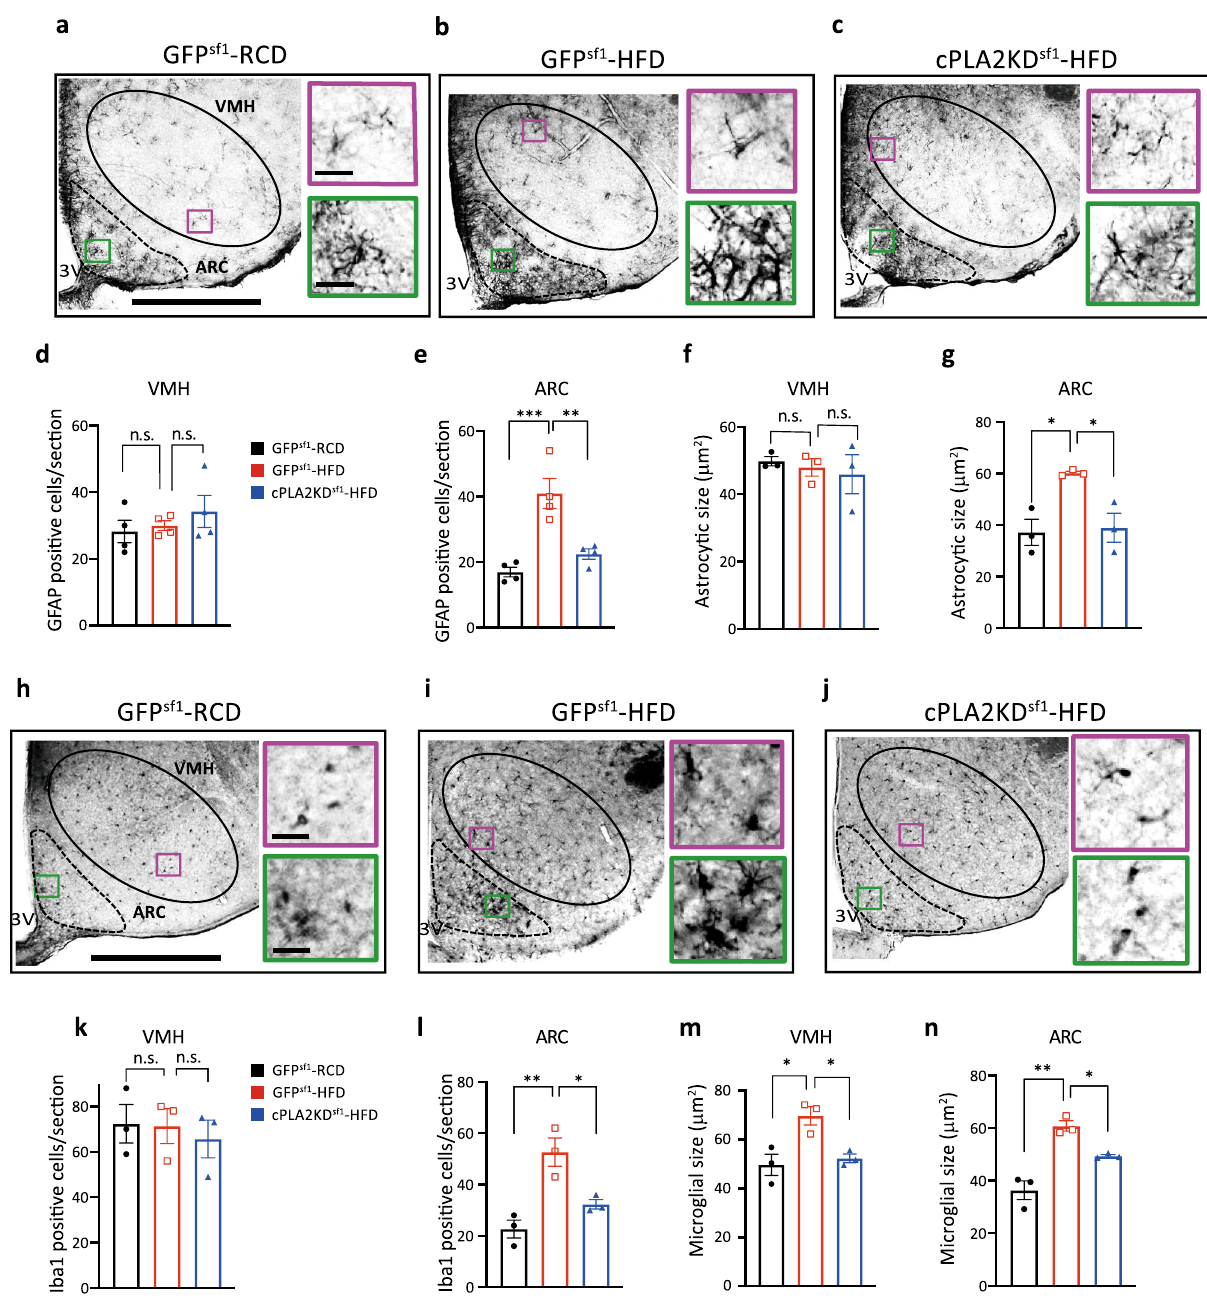
Fig. 6 Knockdown of cPLA2 prevents HFD-induced microgliosis and astrogliosis. a – c Left: representative micrographs showing immunochemistry GFAP staining in the hypothalamus of RCD-fed GFP Sf1 mice (GFP Sf1 -RCD) ( a ), HFD-fed GFP Sf1 mice (GFP Sf1 -HFD) ( b ), and HFD-fed cPLA2KD Sf1 (cPLA2KD Sf1 - HFD) mice ( c ). Scale bar: 500 μ m. Right: magni fi ed areas in the VMH and ARC in the left. Scale bar: 30 μ m. d,e, Quanti fi cation of GFAP-positive cells in the VMH ( d ) or ARC ( e ) of GFP Sf1 -RCD ( n = 4), GFP Sf1 -HFD ( n = 4) and cPLA2KD Sf1 -HFD ( n = 4) mice (one-way ANOVA followed by Sidak multiple comparison test, in e , p = 0.0007 GFP Sf1 RCD vs GFP Sf1 HFD, p = 0.0045 GFP Sf1 HFD vs cPLA2KD Sf1 HFD). f,g , Size of GFAP-positive cells in in the VMH ( f ) or ARC ( g ) of GFP Sf1 -RCD ( n = 3), GFP Sf1 -HFD ( n = 3), and cPLA2KD Sf1 -HFD ( n = 3) mice (one-way ANOVA followed by Sidak multiple comparison test, in g , p = 0.0002 GFP Sf1 RCD vs GFP Sf1 HFD, p = 0.0012 GFP Sf1 HFD vs cPLA2KD Sf1 HFD). h – j Left: Representative micrographs showing immunochemistry Iba1 staining in the hypothalamus of GFP Sf1 -RCD ( h ), GFP Sf1 -HFD ( i ) and cPLA2KD Sf1 -HFD mice ( j ). Scale bar: 500 μ m. Right: magni fi ed areas in the VMH and ARC from the left photos. Scale bar: 30 μ m. k , l Quanti fi cation of Iba1-positive cells in the VMH ( k ) or ARC ( l ) of GFP Sf1 -RCD ( n = 3), GFP Sf1 -HFD ( n = 3), and cPLA2KD Sf1 -HFD ( n = 3) mice (one-way ANOVA followed by Sidak multiple comparison test, in l , p = 0.0049 GFP Sf1 RCD vs GFP Sf1 HFD, p = 0.0310 GFP Sf1 HFD vs cPLA2KD Sf1 HFD). m , n Size of Iba1-positive cells in the VMH ( m ) or ARC ( n ) of GFP Sf1 -RCD ( n = 3), GFP Sf1 -HFD ( n = 3), and cPLA2KD Sf1 -HFD ( n = 3) mice (one-way ANOVA followed by Sidak multiple comparison test, in m , p < 0.0001 GFP Sf1 RCD vs GFP Sf1 HFD, p = 0.0004 GFP Sf1 HFD vs cPLA2KD Sf1 HFD, in n , p < 00001 GFP Sf1 RCD vs GFP Sf1 HFD, p = 0.0004 GFP Sf1 HFD vs cPLA2KD Sf1 ). All data represent the mean ± SEM; * p < 0.05; ** p < 0.01; *** p <